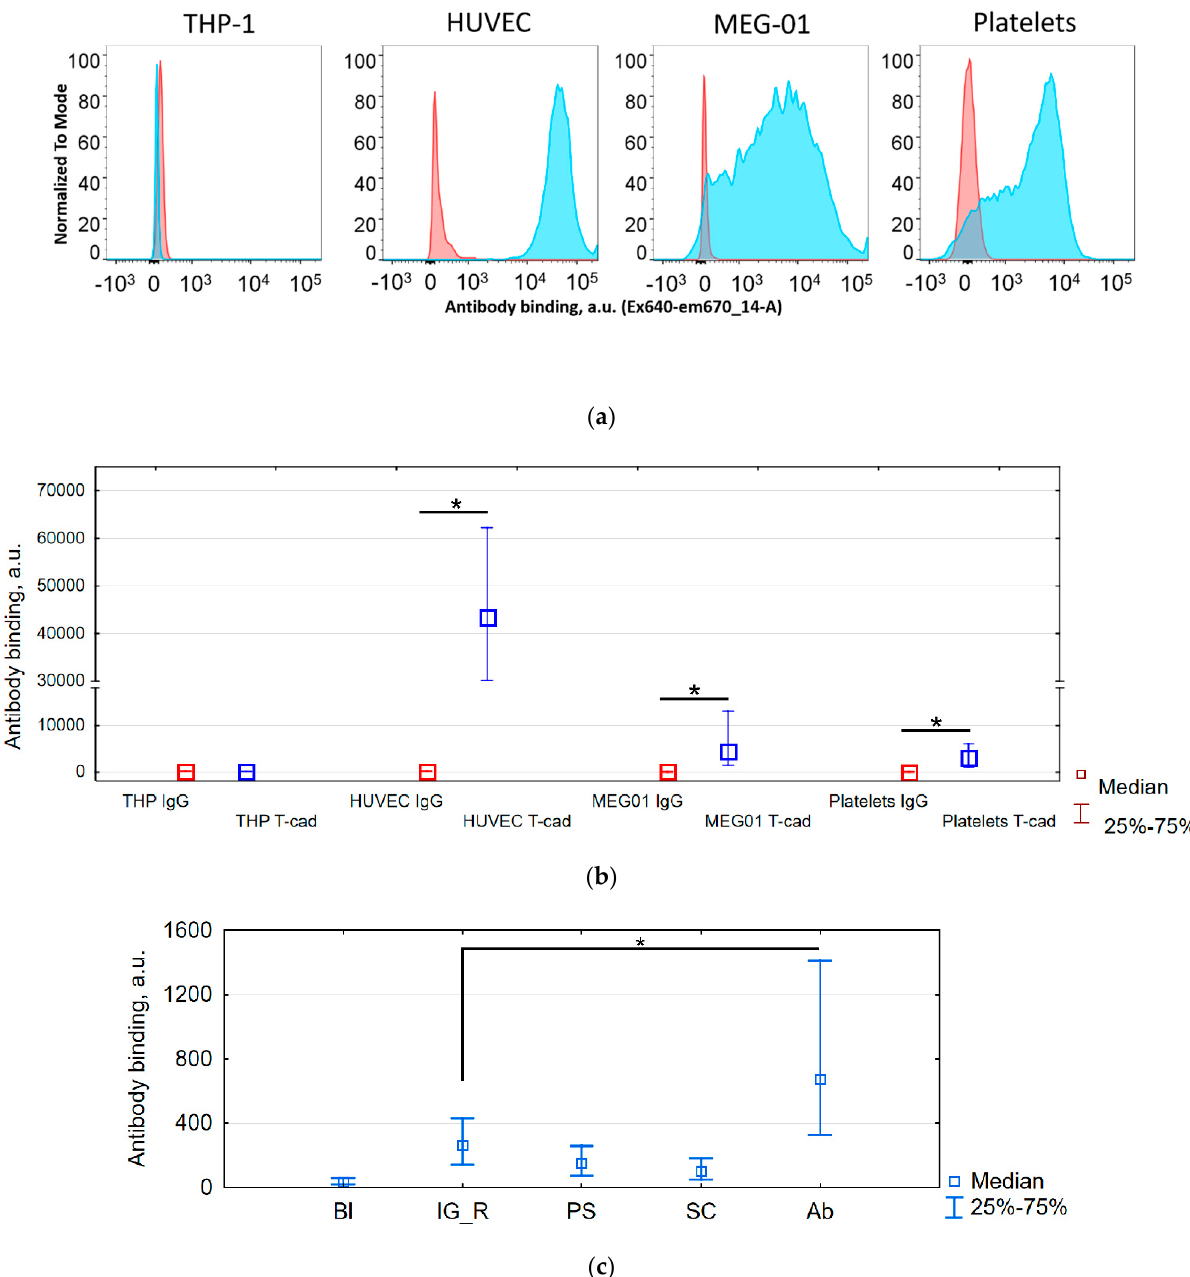
Figure 1. Specific binding of anti-T-cadherin antibodies to megakaryocytes MEG-01 and platelets compared with negative THP-1 control and positive human umbilical vein endothelial cells (HUVEC) control according to flow cytometry data. Forward scatter /Side scatter gates were cell specific and channel voltage for detection of T-cadherin (ex640 em670/14) was the same for all cells (THP-1, HUVEC, MEG-01) and different for platelets. ( a ) Distribution histograms of cells incubated with antibodies anti-T-cadherin (blue) or isotypic control (red). ( b ) Median and percentiles of the fluorescence (antibody binding) for the above histograms. * The binding of the specific antibody is greater than of the isotype control, p < 0.001. n = 5. ( c ) Median and percentiles of the fluorescence (antibody binding) for blank sample without antibody (Bl), sample with rabbit IgG (IG_R), ProSci (PS), SantaCruz (SC), and Abnova (Ab) antibodies. * The binding of the specific antibody is greater than of the isotype control, p < 0.001. n = 2.